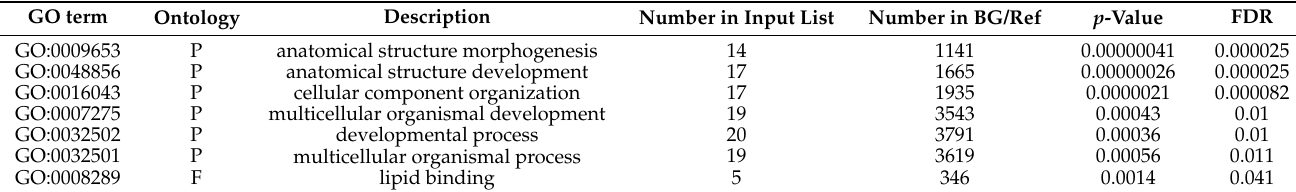
Table 3. GO enrichment analysis of 132 upregulated differential expressed genes